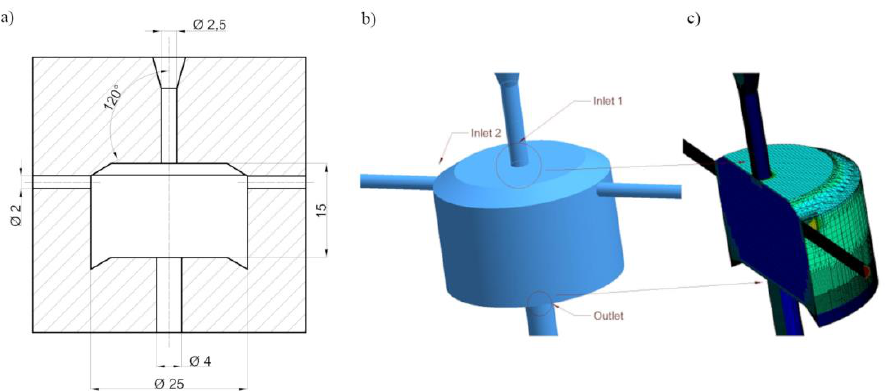
Figure 1. A simplified physical model of the pulse head: a scheme of the construction ( a ), computer model ( b ), model after meshing ( c ).